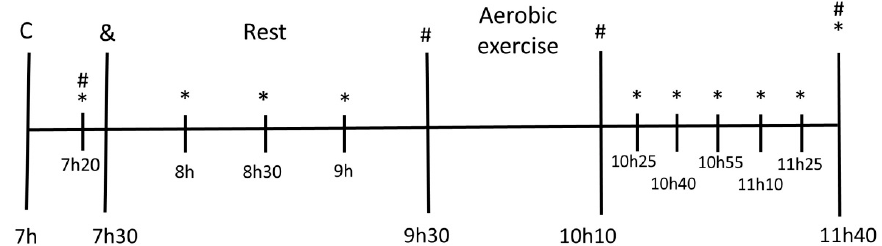
Figure 1. Experimental design of the sessions. (C) Arrival at the laboratory; (*) Blood pressure measurement; (#) Saliva sample collection; (&) Beverage intake.